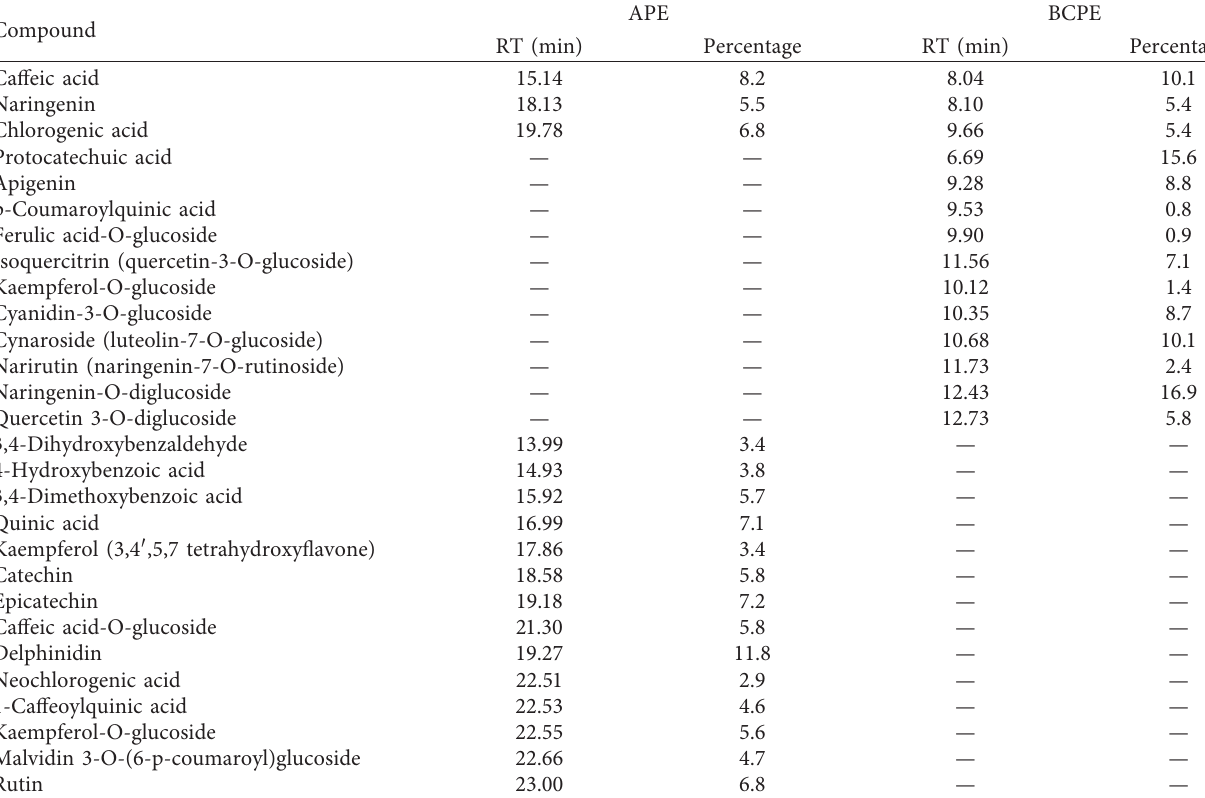
Table 1: LC-MS analysis result of aqueous black currant and apricot pomaces